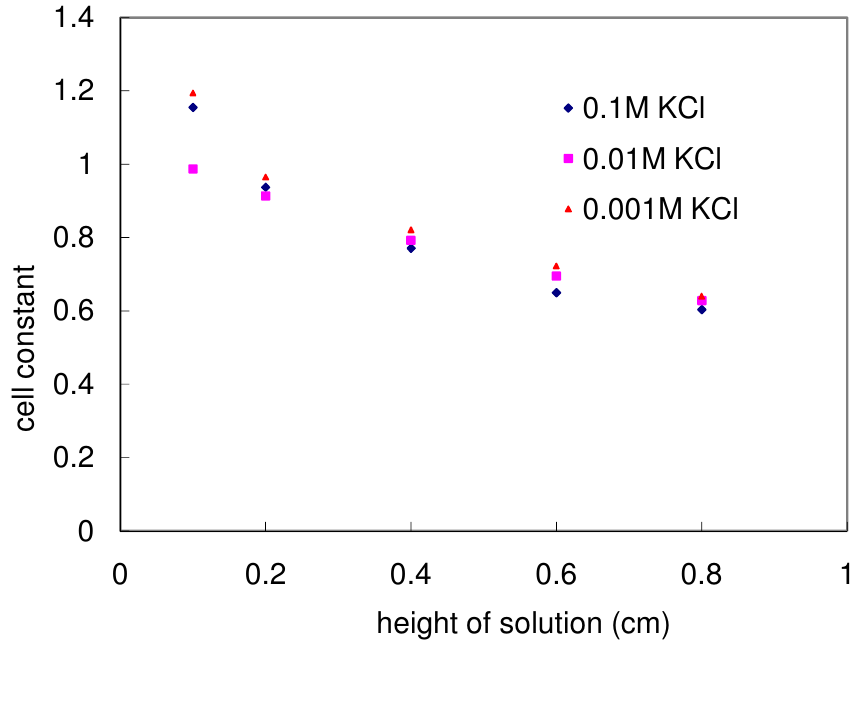
Figure 8. Cell constant as a function of solution thickness for three reference KCl solutions: cell constant decreases negligibly with KCl solution concentration as solution thickness